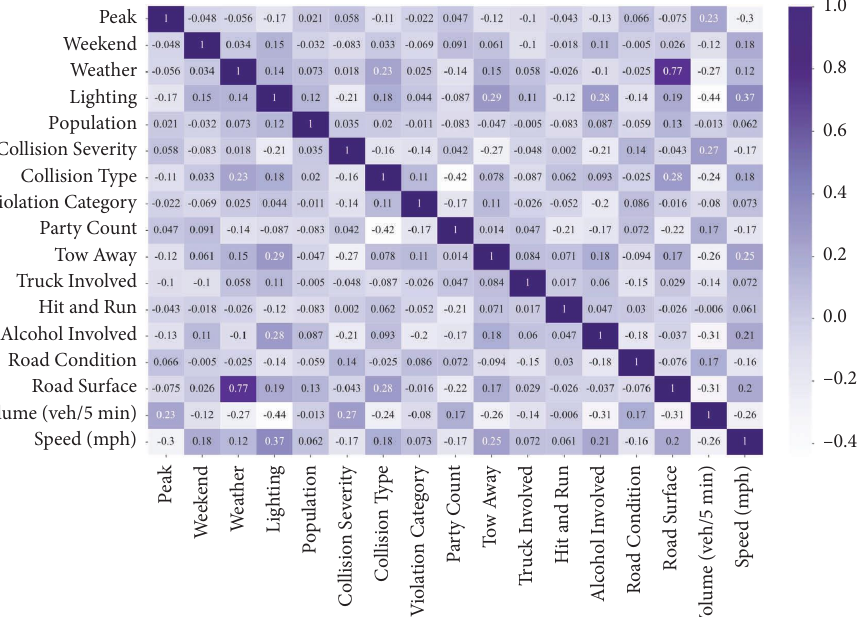
Figure 1: Pearson correlation coefcients of